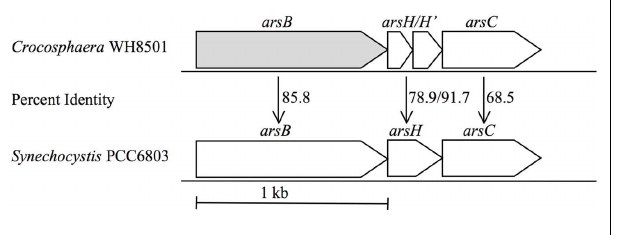
FIGURE 2 |The gene topology of C. watsonii WH8501 arsCHB and percent identity to Synechocystis PCC6803. Genes shaded gray have been shown to be up-regulated by phosphorus stress, or arsenate addition in this